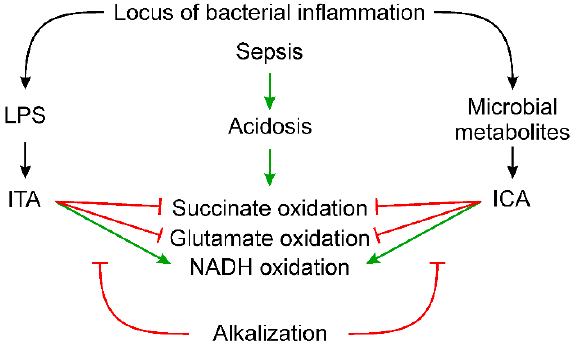
Figure 8. Influence of LPS and microbial metabolites on succinate, glutamate and NADH oxidation